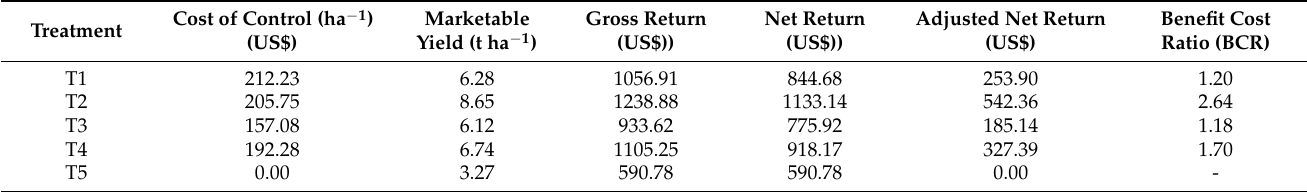
Table 5. Economic analysis of different treatments against the okra shoot and fruit borer of okra (t ha − 1 ) grown during summer season.